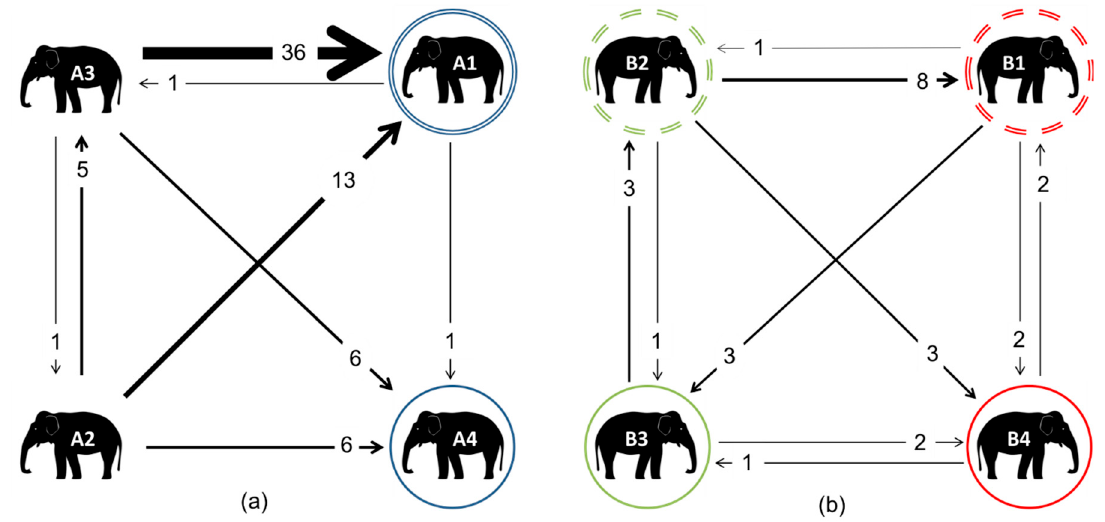
Figure 6. Weighted digraphs based upon agonistic interactions for the elephants at Zoo A ( a ) and Zoo B ( b ). The double circles indicate mothers, whilst matching coloured solid circles indicate their daughters. In Zoo B, all of the individuals were related: dashed circles indicate siblings; their daughters B3 and B4 are therefore cousins, and nieces to the other sibling.